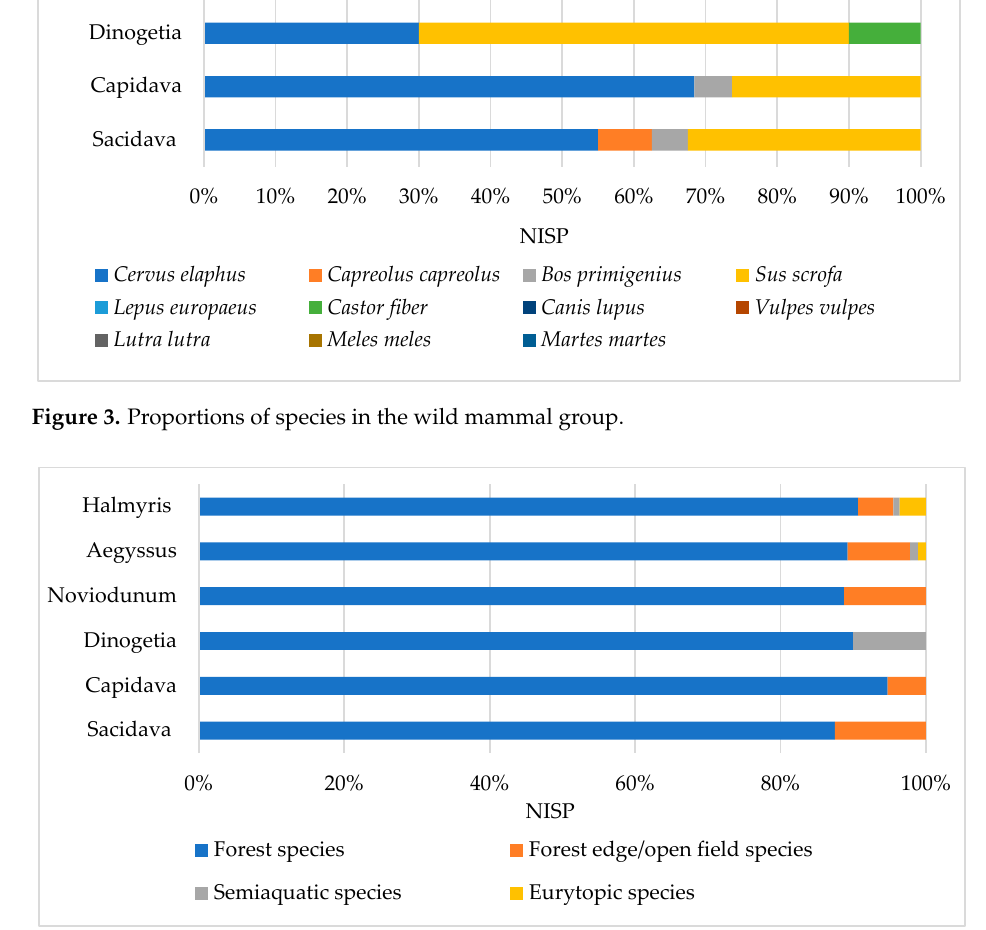
Figure 4. Proportions of wild mammal species by ecological group.